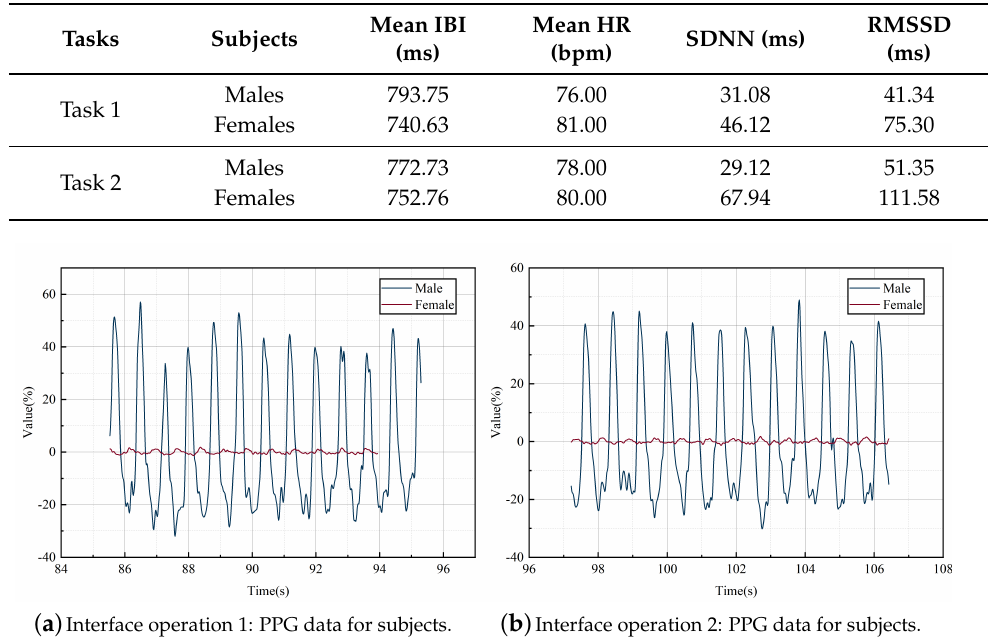
Figure 5. Changes in subject PPG data during interface operation. A graph of the changes in the PPG of subjects of different genders throughout the experiment, produced after processing by Origin data analysis